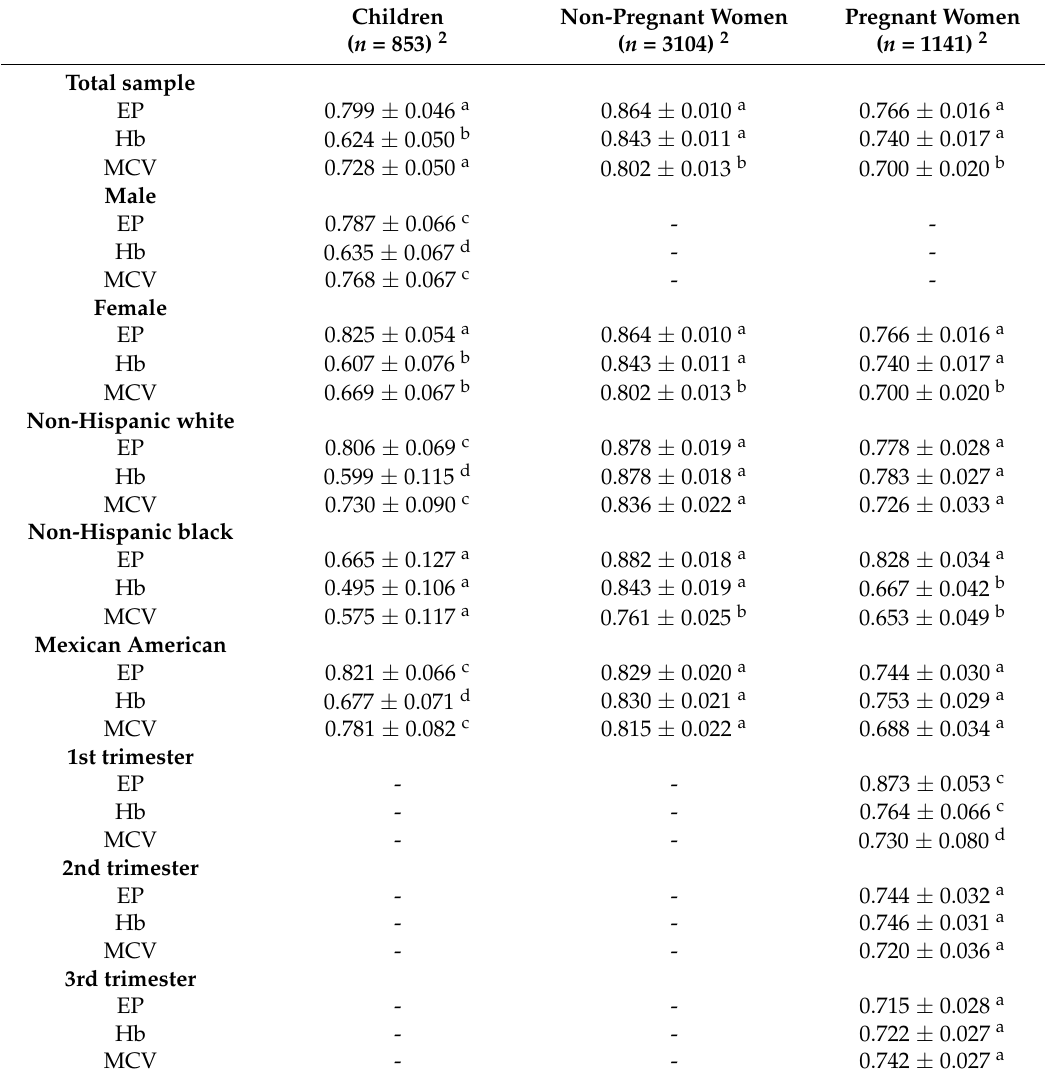
Table 2. Comparison of the areas under the ROC curves (Mean ± SE) of erythrocyte protoporphyrin (EP), hemoglobin (Hb), and mean cell volume (MCV) in detecting iron deficiency in children (three to five years old), non-pregnant women (15–49 years), and pregnant women from the National Health and Nutrition Examination Surveys (NHANES, 2003–2006 for children and non-pregnant women, 1999–2006 for pregnant women) 1